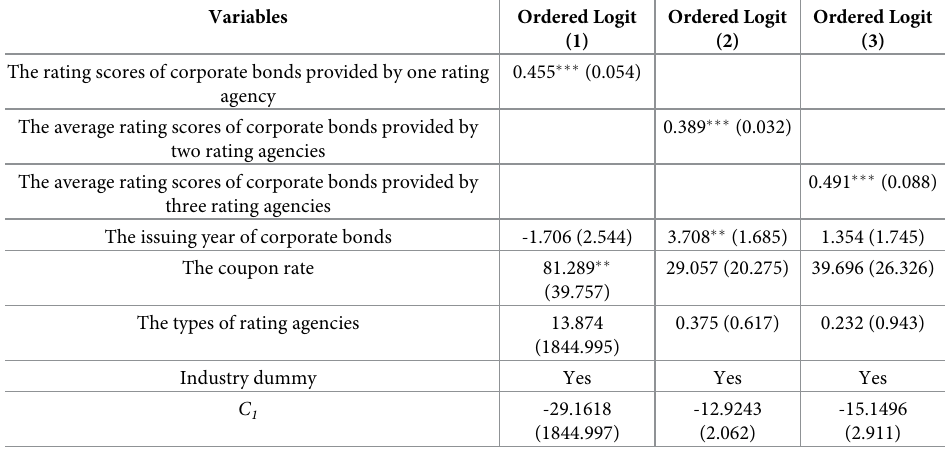
Table 8. Regression results of rating